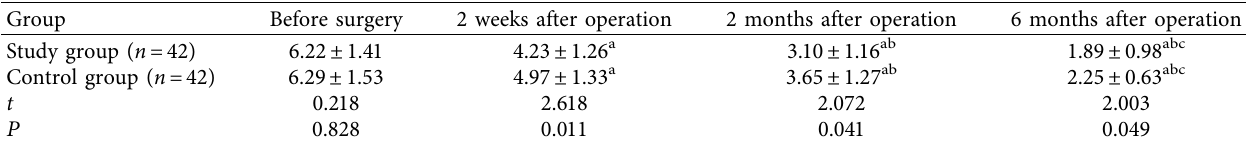
Table 3: Comparison of VAS scores of patients between the two groups before and at each time point after surgery ( x ± S , score). Group Before